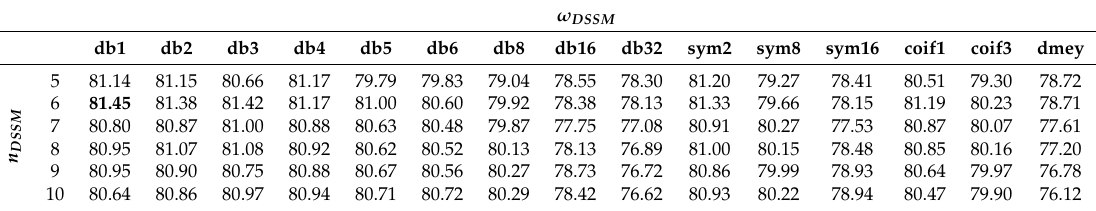
Table 9. The accuracy (%) of five class sleep stage classification with different wavelet bases and different order of DSSM under R&K standard. Only DSSMFs are used, no LEFs.